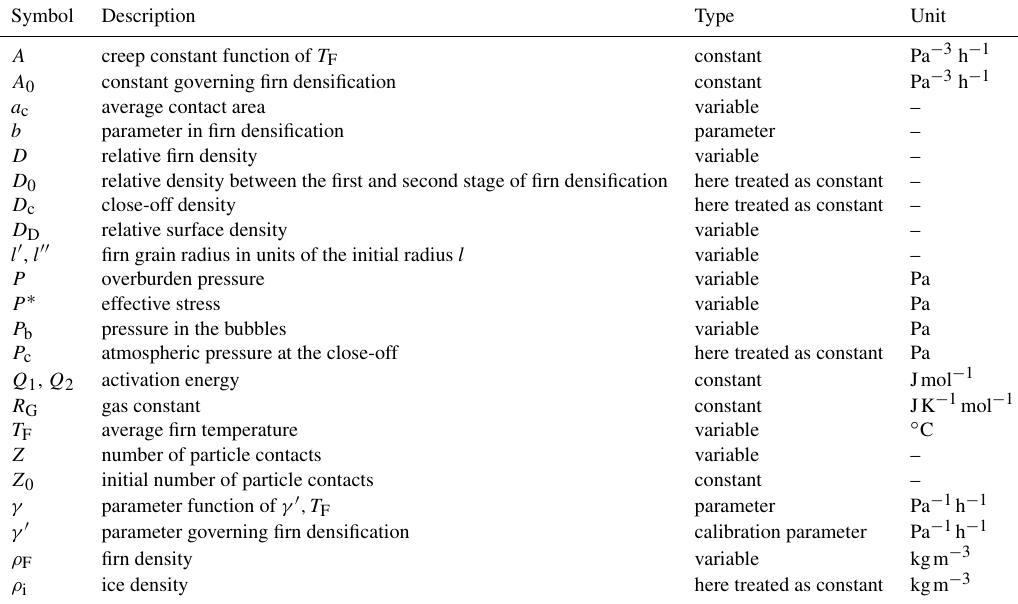
Table B4. List of the symbols used in AR.